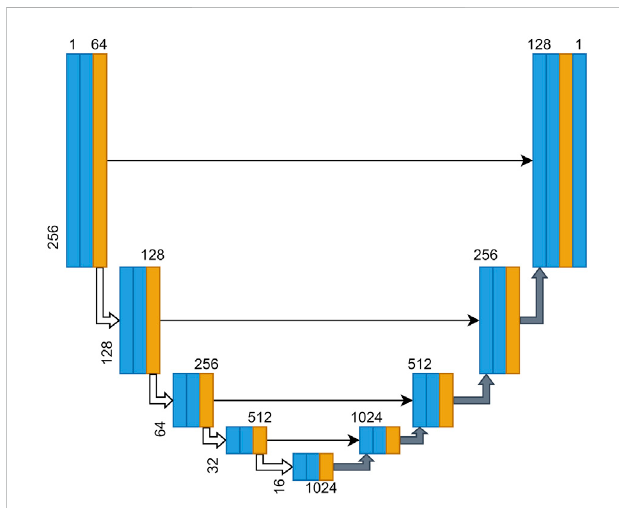
FIGURE 5 U-Net architecture used in this study. The U-Net have 4 downsample blocks and 5 upsample blocks. These corresponding blocks are connected by